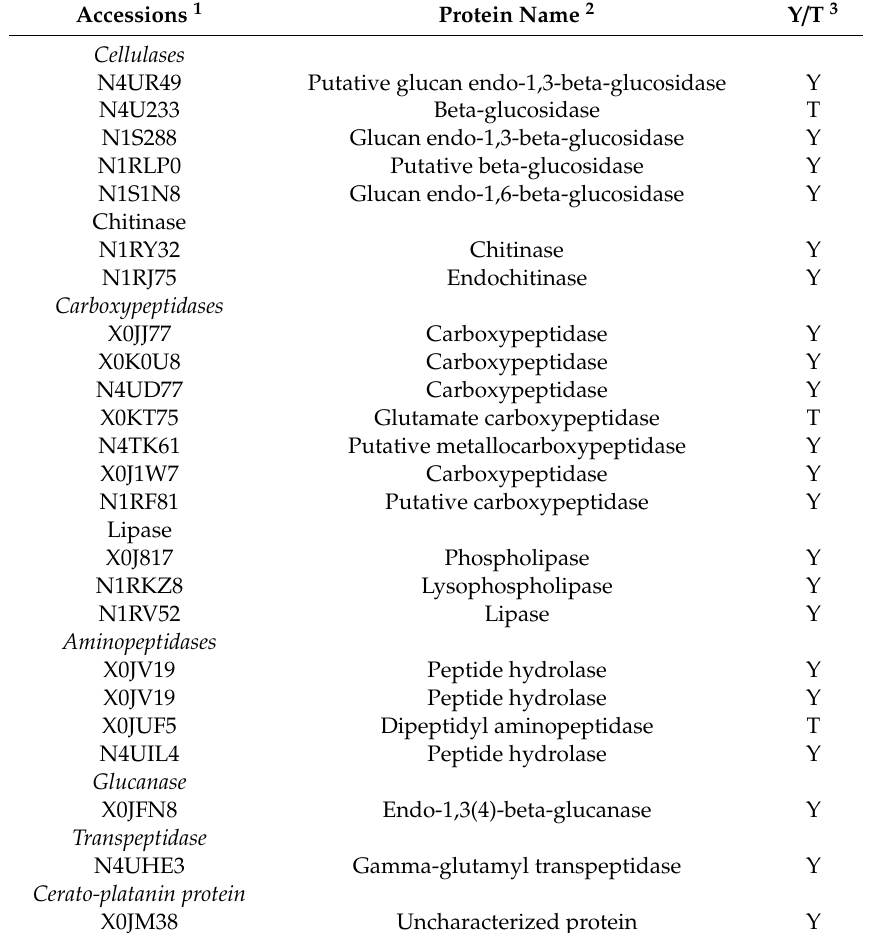
Table 1. Putative pathogen–host interaction proteins in the